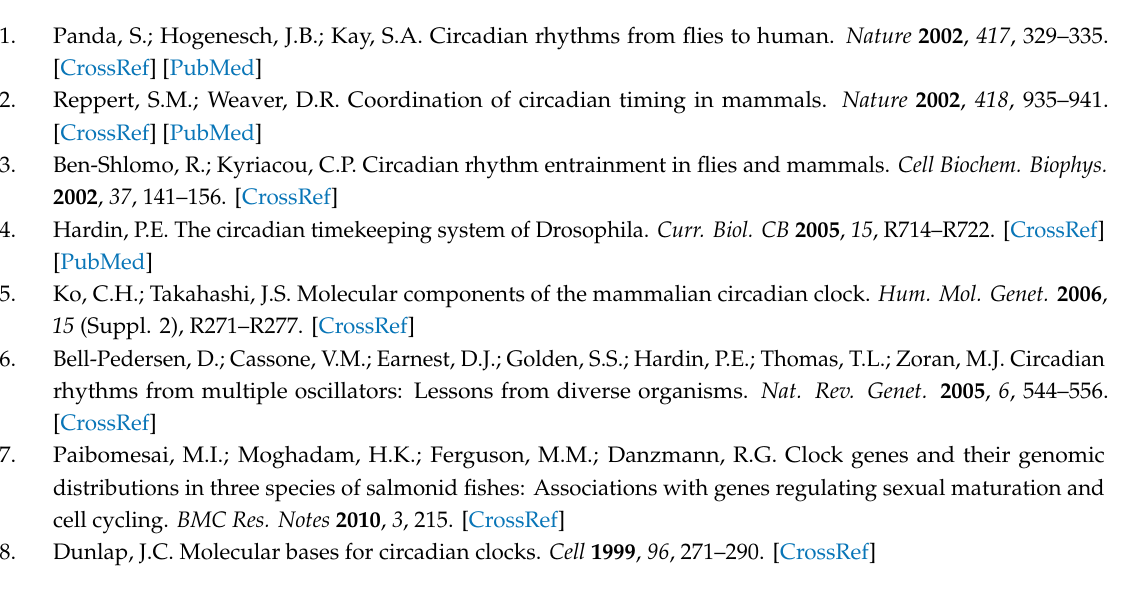
Table S1: The 226 circadian clock genes used for phylogenetic analyses, Table S2: The regulatory elements in upstream regions of per1 genes, Table S3: The regulatory elements in upstream regions of per2 genes. Figure S1: The conserved syntenic analyses of (A) clock family, (B) tim family, (C) bmal family, (D) per family, (E) ror family and (F) dec family. The chromosome models of several organisms with genes are displayed. The chromosome number or linkage group number is shown to right of the chromosomes. The same colored rectangles represent the orthologous